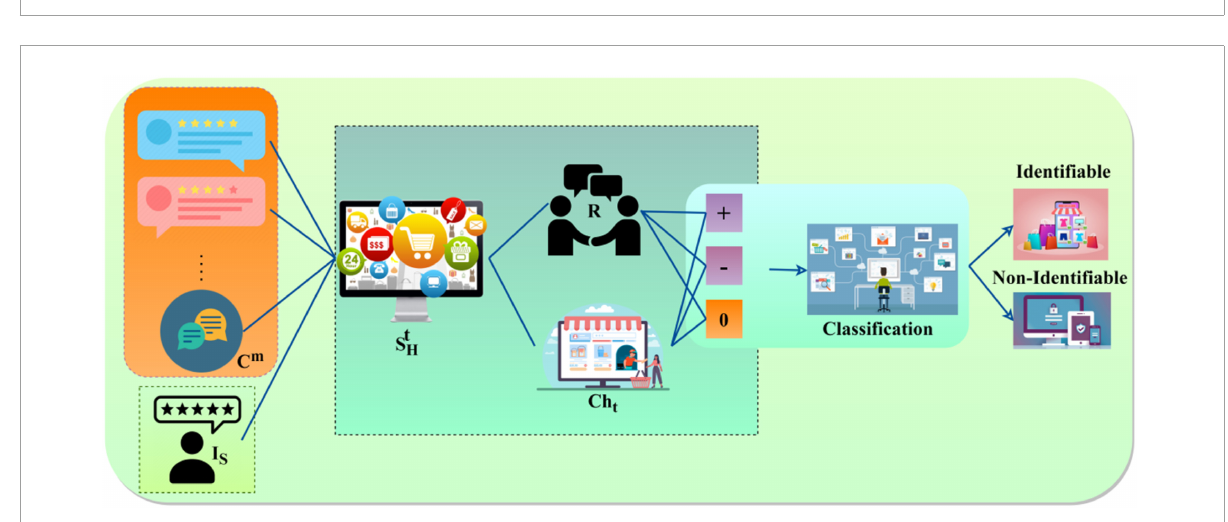
FIGURE2 Comment (information) classification